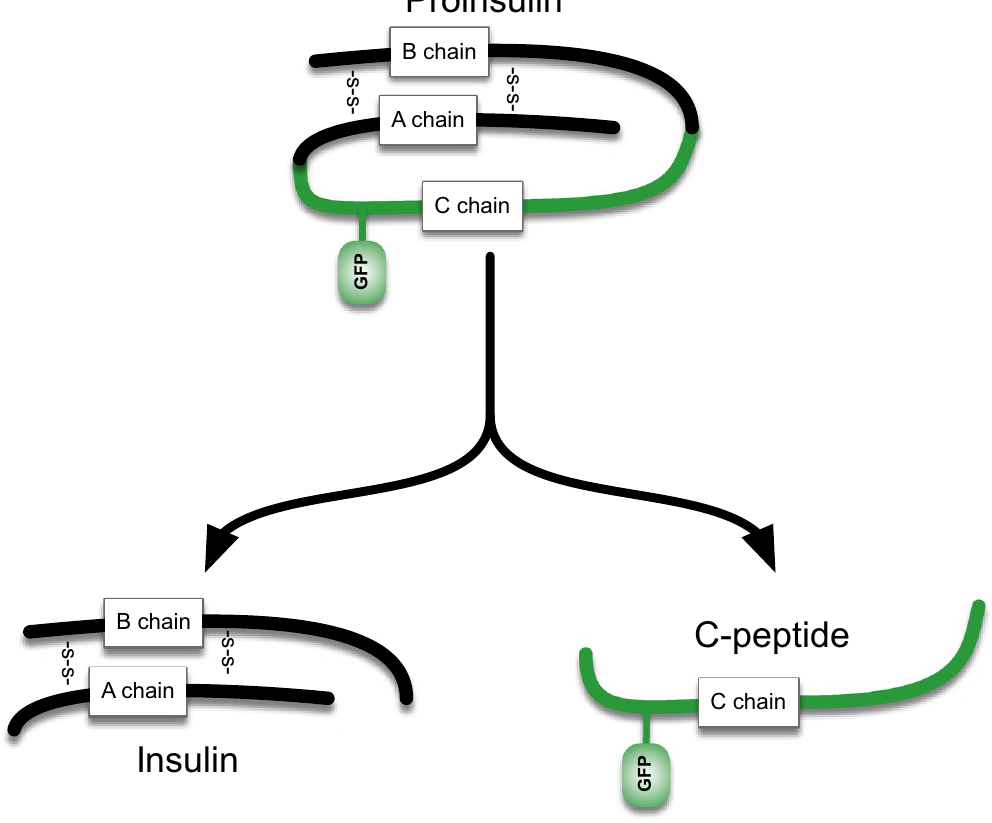
Figure 1. CpepSfGFP diagram. Diagram of the structure of the proinsulin with the super folder GFP (sfGFP) tag attached to it. Processing the proinsulin separates the normal insulin (left) from the CPeptide with the sfGFP tag attached to it